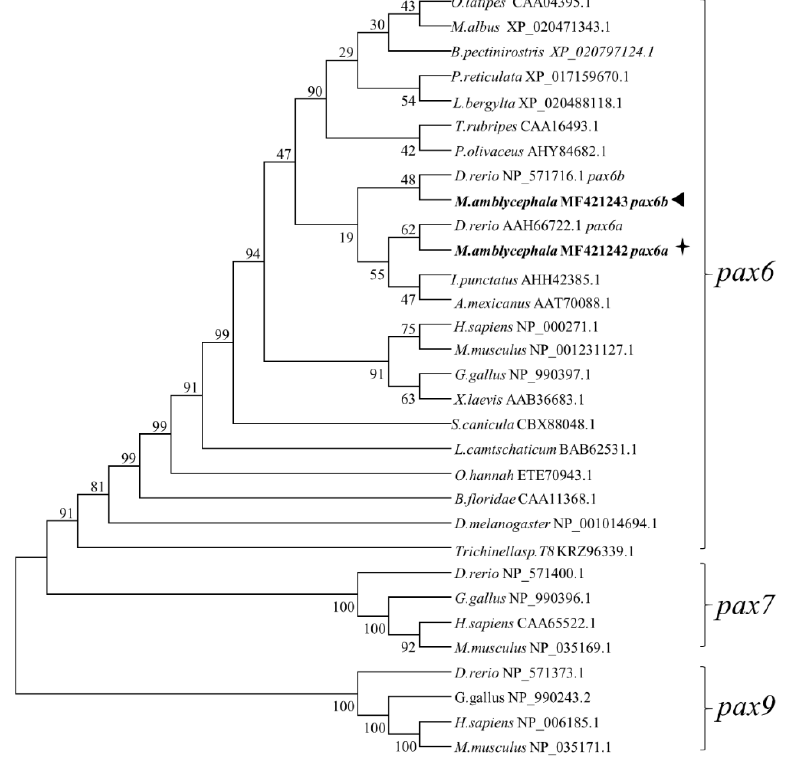
Figure 2. Molecular phylogenetic analysis of pax6 homologs. The phylogenetic relationship of PAX family proteins was analyzed using the MEGA6 program by bootstrap analysis using neighbor-joining (1000 replicates). The numbers at the forks are the bootstrap proportions for each branch. A star indicates Mapax6a, and a triangle indicates Mapax6b.